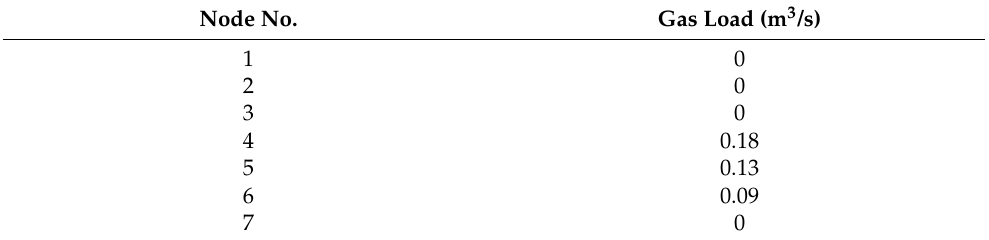
Table A2. Gas load of the seven-node natural gas network in the case study. Node No.